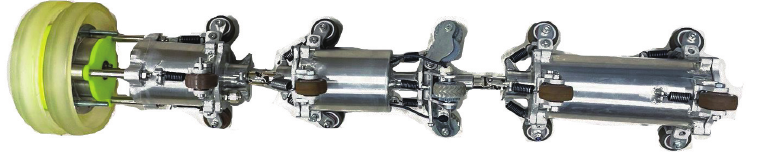
Figure 14. Actual view of the prototype.